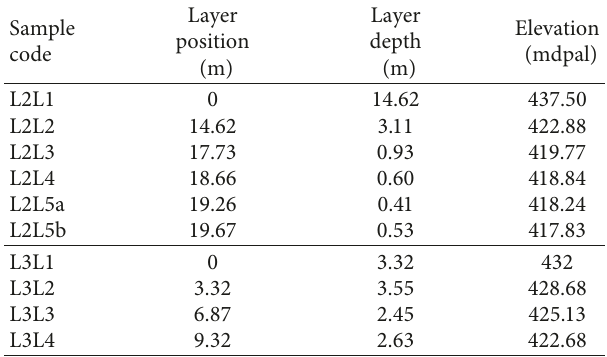
Table 2: Selective samples of clay layer depth.